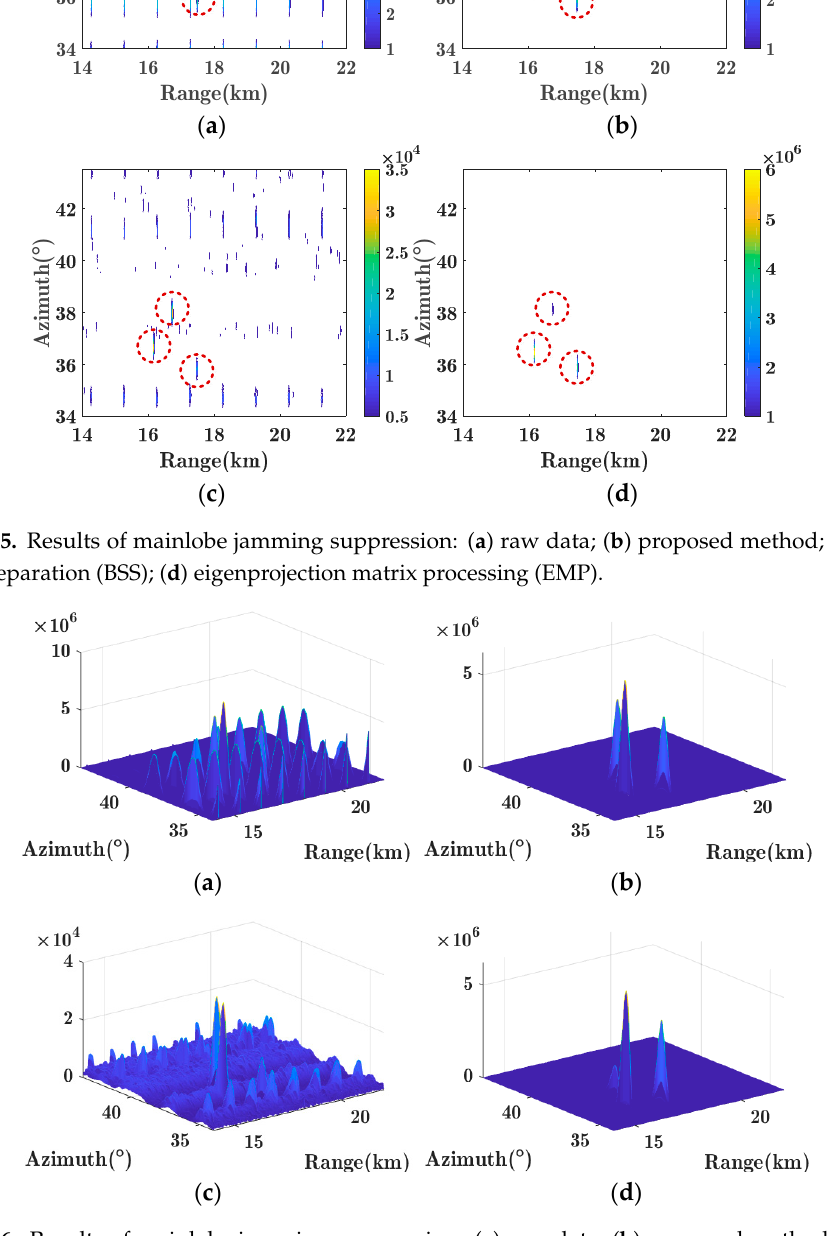
Figure 16. Results of mainlobe jamming suppression: ( a ) raw data; ( b ) proposed method; ( c ) BSS; ( d ) EMP.